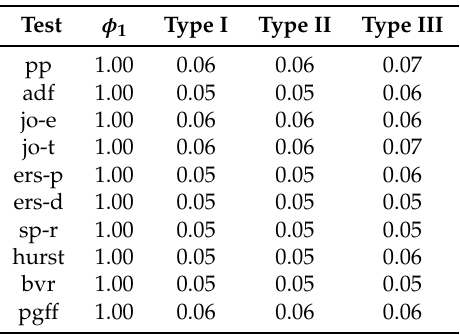
Table 8. Size of cointegration tests for Monte Carlo settings of Type I, Type II and Type III, as described in Subsection